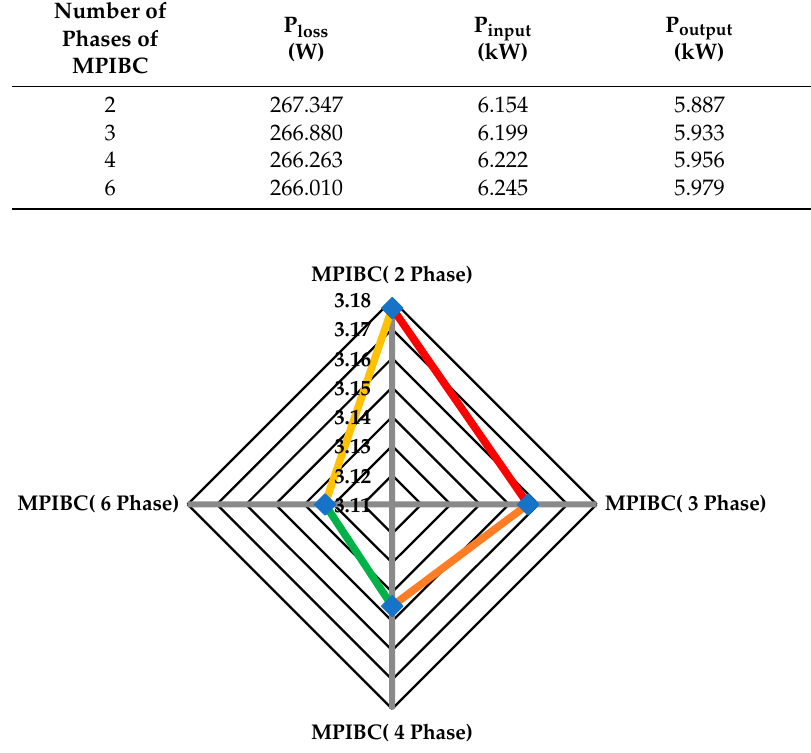
Figure 6. Total power loss comparison of MPIBC (input voltage: 20 V).